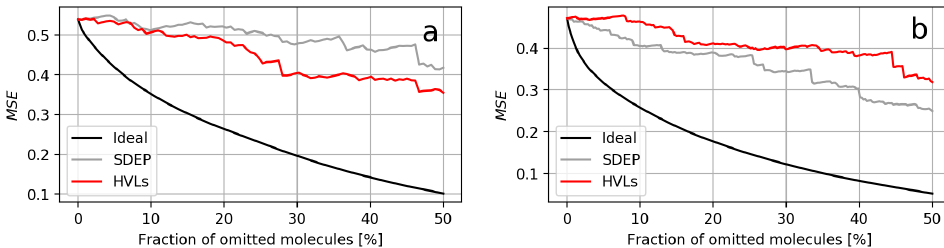
Figure 3. Two confidence curve plots from models using ECFPs. ( a ) Plot of dataset P16581, for which HVLs had the smallest area compared to that of the SDEP. ( b ) Plot of dataset Q05397, for which HVLs had the largest area compared to that of the SDEP.